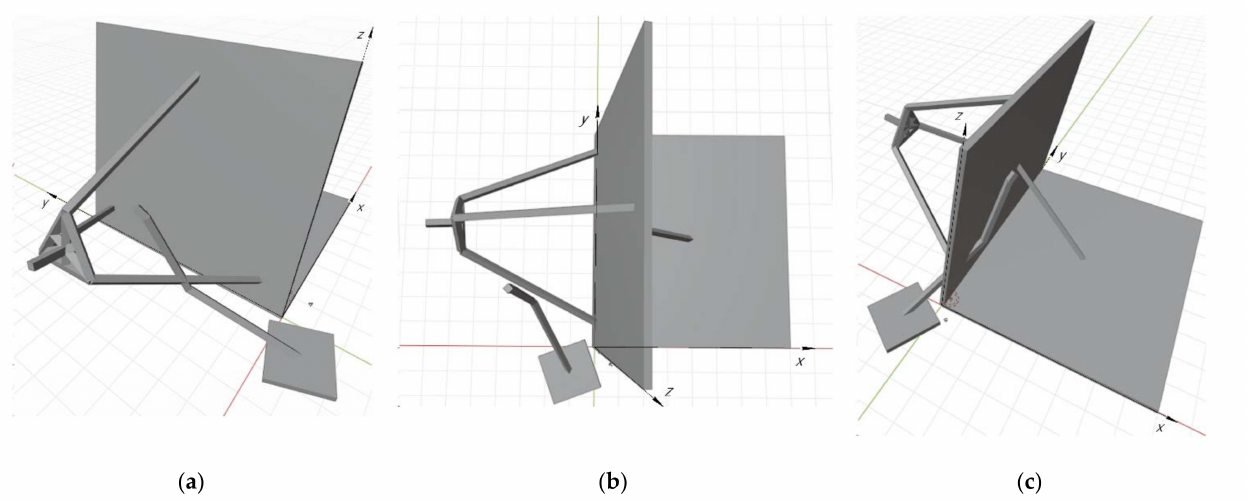
Figure 12. Relative position of the multi-robotic system—( a ) the presence of an intersection between the links of the manipulators, ( b ) the absence of intersections, ( c ) the intersection of the serial manipulator with the rotating platform of the parallel